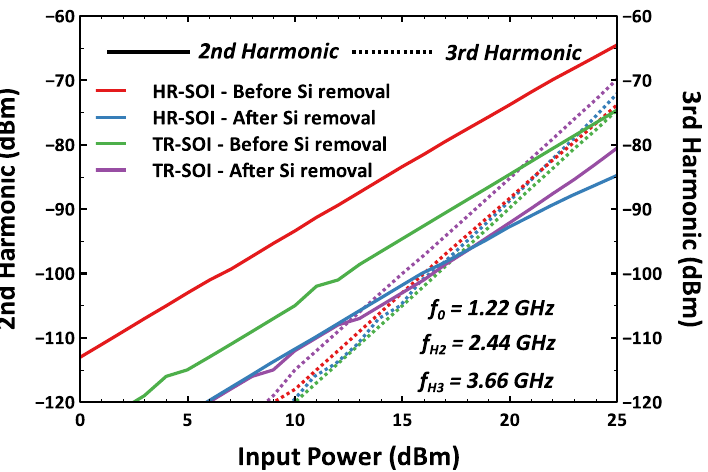
Figure 13. Harmonic distortion shown for a sample with gate length of 220 nm and V biasON = 2.5 V.